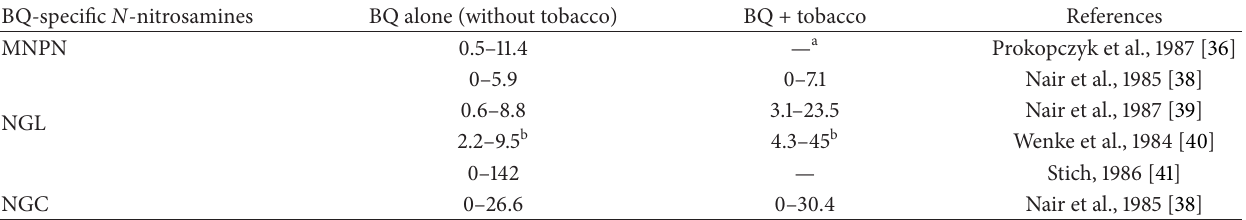
Table 1: Detected saliva levels (ng/mL) of nitrosamines such as MNPN, NGL, and NGC in chewers with tobacco and without